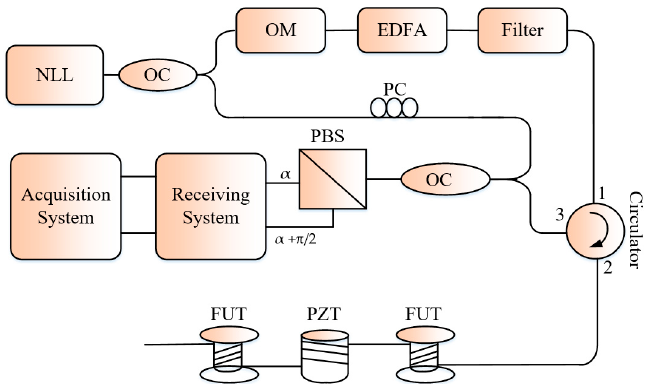
Figure 4. Schematic of the polarization diversity technique in Φ -OTDR system. OC: optical coupler PC: polarization controller.